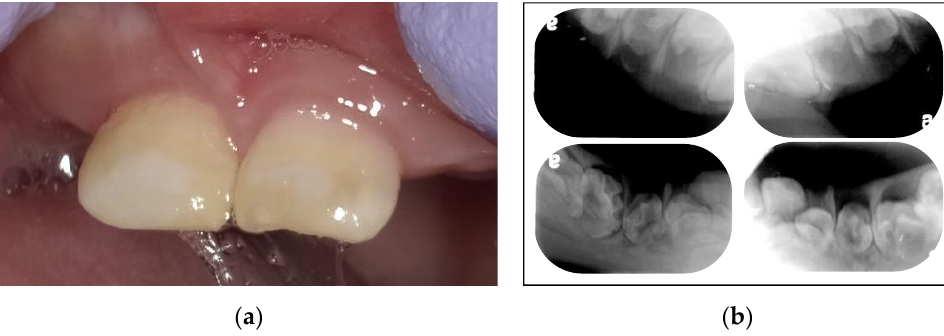
Figure 1. ( a ) Intraoral photograph acquired at the age of 3 years and 2 months. ( b ) Periapical radiograph images acquired at the age of 3 years and 2 months.